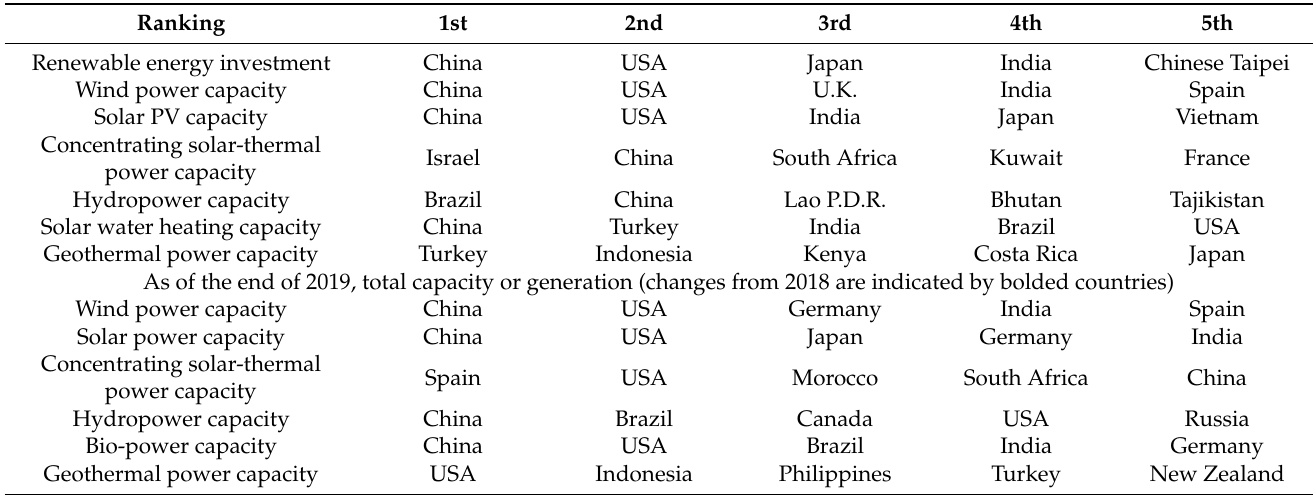
Table 2. Worldwide ranking in annual investment/net capacity additions/production (at the end of 2019). Source: Renewable energy policy network for the 21st century (REN21) [25].